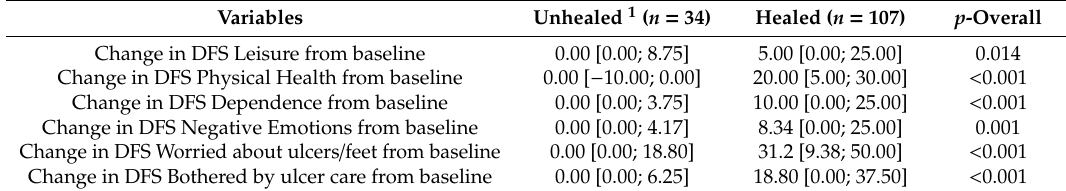
Table 4. Summary of the descriptive analysis of sensitivity to change assessment of Diabetes Foot Ulcer Scale-Short Form (DFS-SF) subscales according to healed / unhealed group. Variables Unhealed 1 ( n = 34) Healed ( n = 107) p -Overall Change in DFS Leisure from baseline 0.00 [0.00; 8.75] 5.00 [0.00; 25.00] 0.014 Change in DFS Physical Health from baseline 0.00 [ − 10.00; 0.00] 20.00 [5.00; 30.00] < 0.001 Change in DFS Dependence from baseline 0.00 [0.00; 3.75] 10.00 [0.00; 25.00] < 0.001 Change in DFS Negative Emotions from baseline 0.00 [0.00; 4.17] 8.34 [0.00; 25.00] 0.001 Change in DFS Worried about ulcers / feet from baseline 0.00 [0.00; 18.80] 31.2 [9.38; 50.00] < 0.001 Change in DFS Bothered by ulcer care from